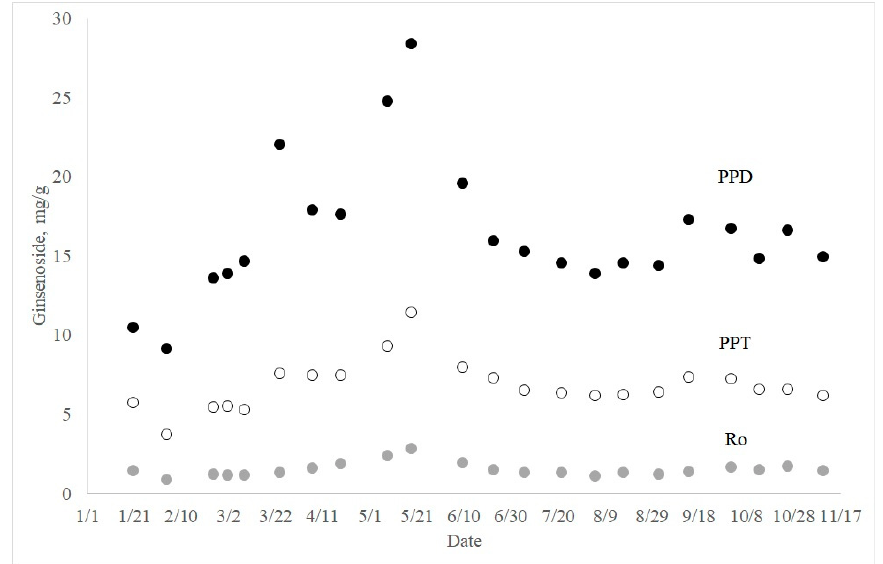
Figure 3. PPD, PPT, and ginsenoside Ro changes of five-year-old ginseng throughout the year.